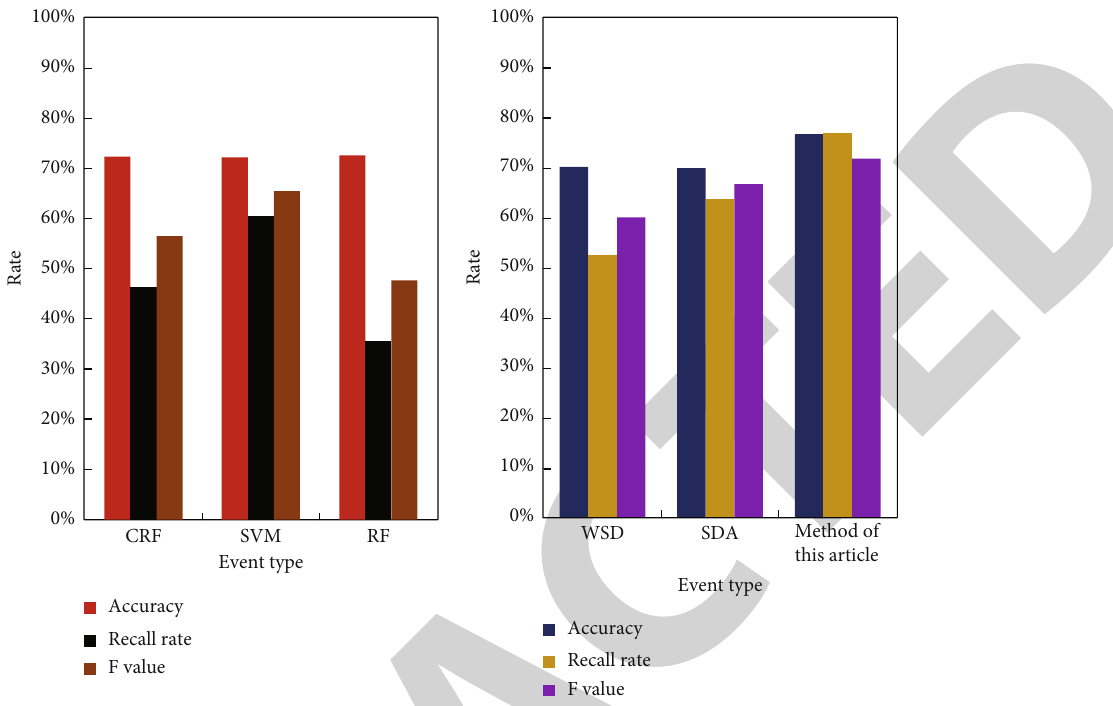
Figure 7: Compared with traditional machine learning